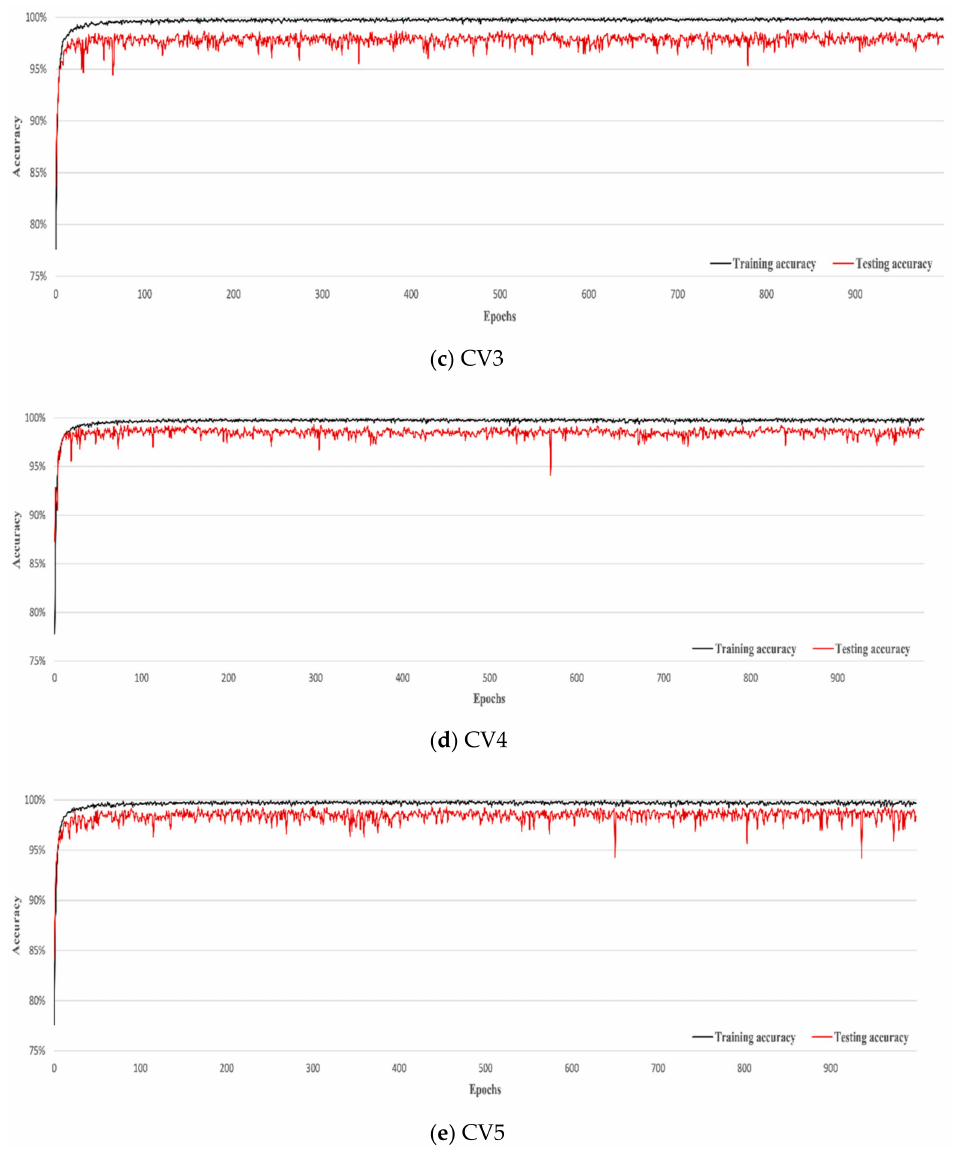
Figure 3. Convergence curves of the fivefold cross-validation of training accuracy and testing accuracy. Table 5. Experiment results of fivefold the